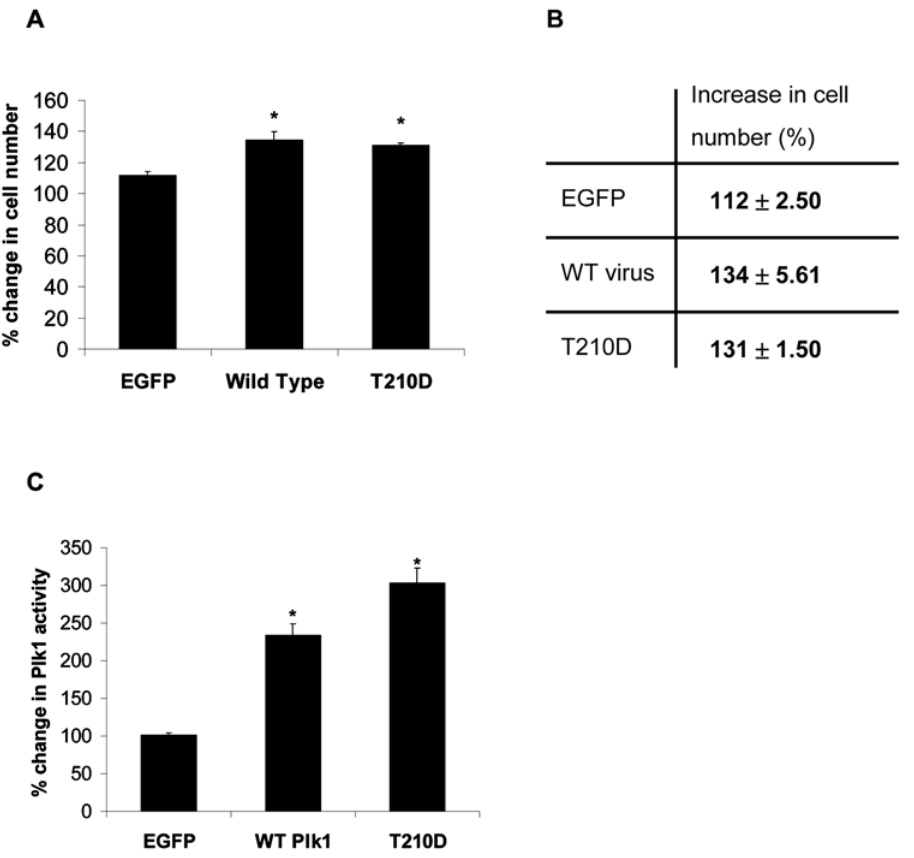
Figure 4. Effect of adenovirus-delivered Plk1 on HeLa cell number and Plk1 activity. Plk1 enhanced cell division in HeLa cells at 48 hours post infection (A and B). The activity of adenovirus-delivered Plk1 was assessed in P10 cardiac myocytes (C).